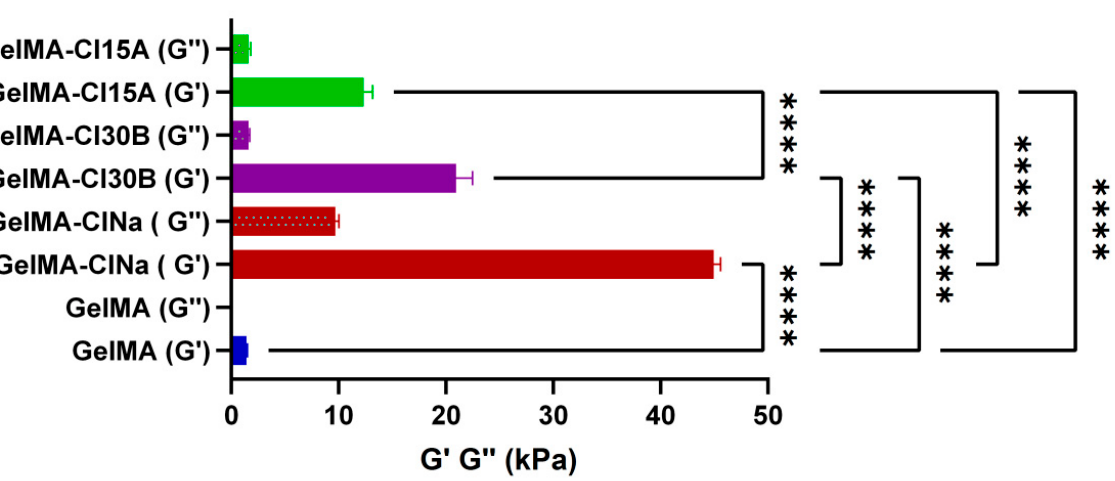
Figure 7. Storage and loss moduli determined by nanoindentation on equilibrium swollen samples. Statistical significance: **** p < 0.0001.